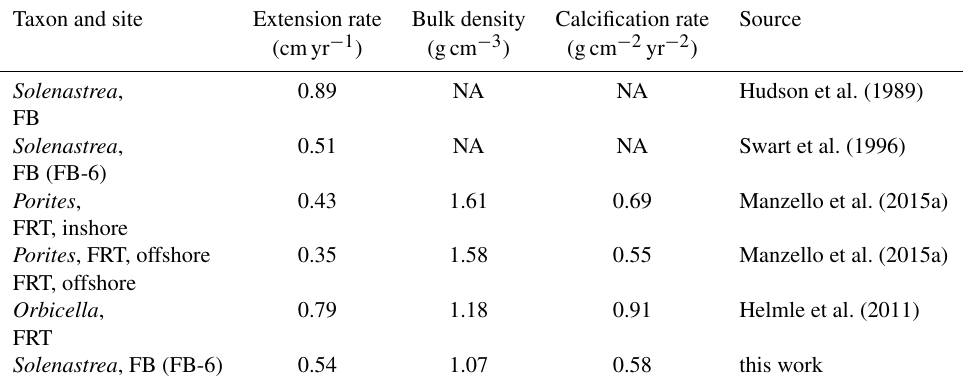
Table 4. Calcification data from recent z corals, southern